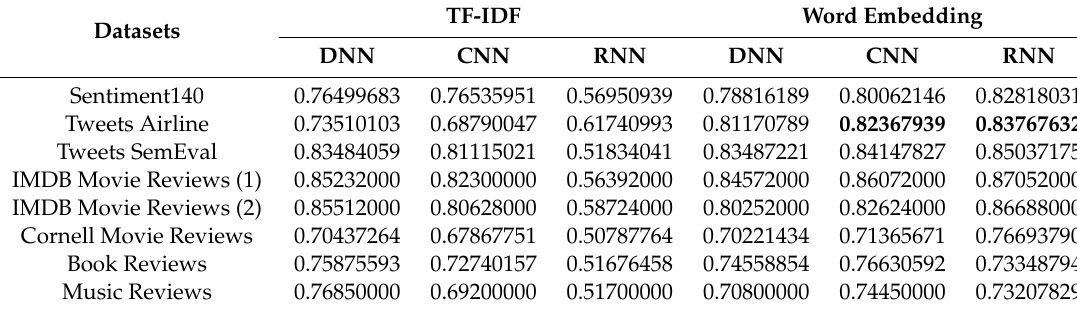
Table 6. The AUC comparison for di ff erent